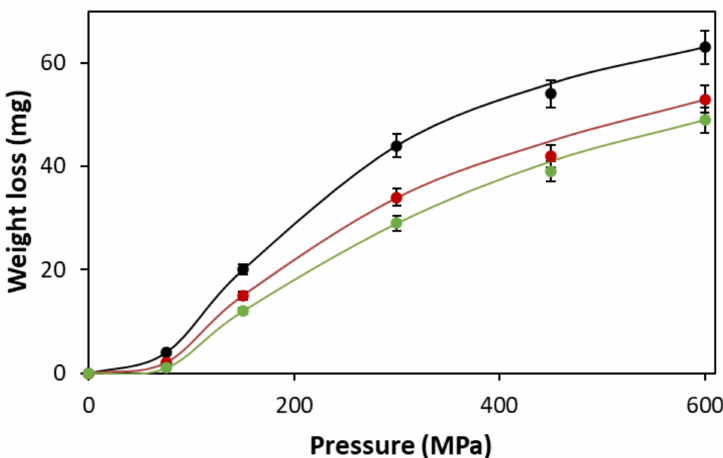
Figure 4. Measured mass of water loss vs. applied pressure plots for 500 mg of a 61 wt% water-loaded silica gel/PTFE powder placed under different high pressures for 3 min (black dots), 2 min (red dots), or 1 min (green dots). All work was carried out at 20 ◦